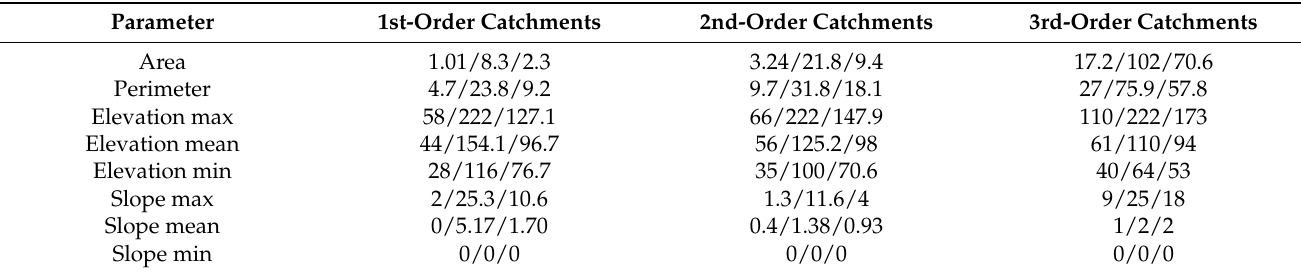
Table 2. Morphometrical results associated with catchments and encompassing area (km 2 ), perimeter (km), elevations (m asl) and slopes ( ◦ ). Results are to be understood as follows: minimum/maximum/mean.